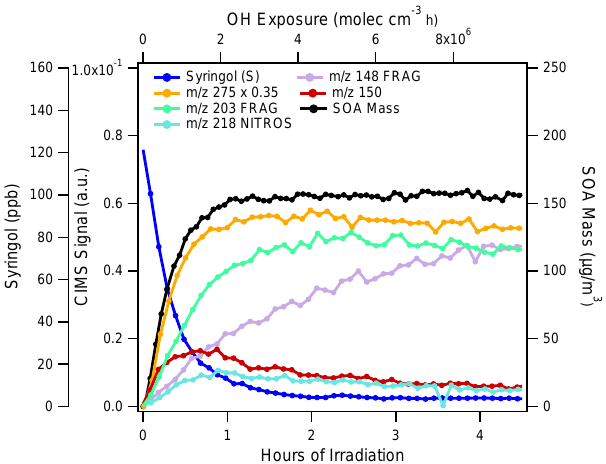
Fig. A2. Syringol high-NO x gas-phase and particle-phase develop-